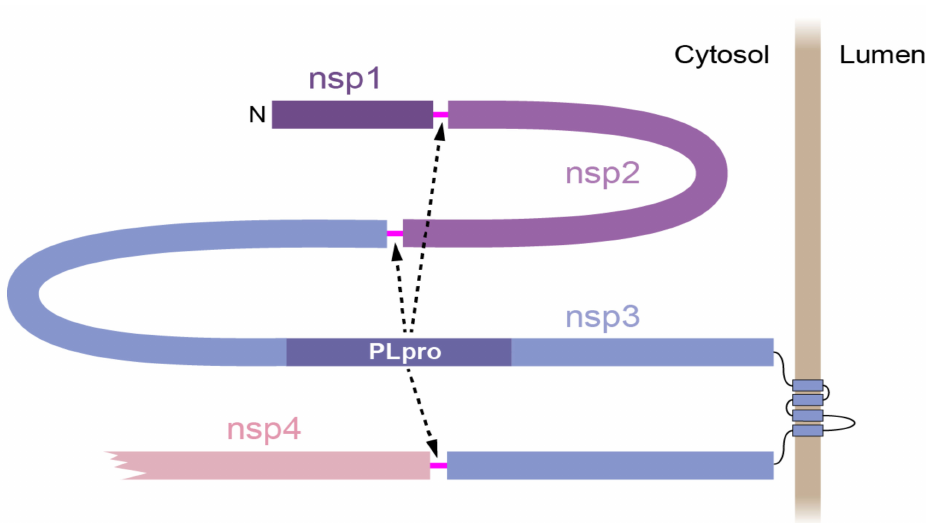
Figure 1. Schematic representation of an N-terminal part of the SARS-CoV-2 polyprotein ORF1a/1b. Nsp1, nsp2, and nsp3 with PLpro domain and four transmembrane segments (across endoplasmic reticulum membrane, shown as vertical brown bar) as well as a part of nsp4 are shown. PLpro cleavage sites (magenta) are between nsp1, nsp2, nsp3, and